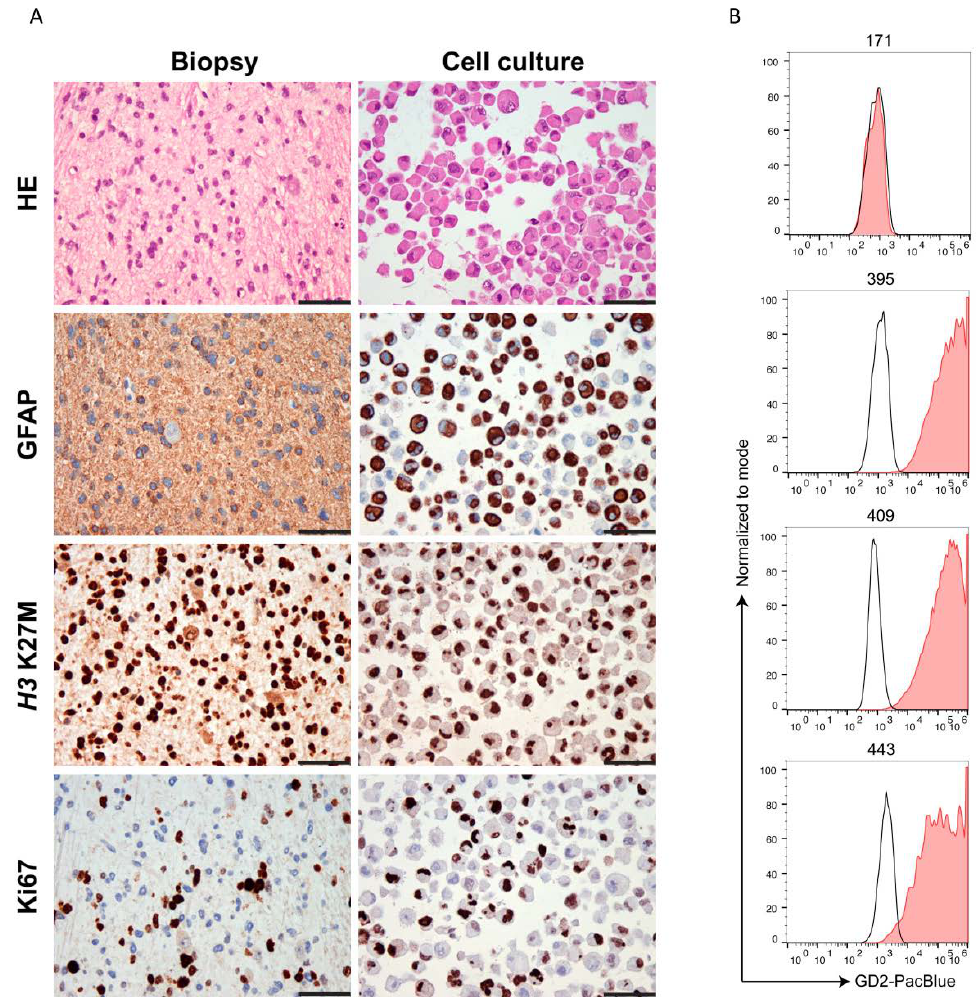
Figure 3. H3K27M-mutant DMG express high and homogeneous amount of GD2. ( A ). Validation of H3K27M-mutant DMG primary cells. Primary tumor cells of patient no. 395 were embedded in paraffin, stained with hematoxylin eosin (HE), and further analyzed by IHC with the indicated antibodies. The tumor used for the isolation of the primary cells was used as reference (biopsy, left panel). The H3K27M mutation was maintained in the cell culture. GFAP and Ki67 staining was similar between the biopsy and the primary cells. Scale bar: 50 µ m. Similar results were obtained with sample 409. ( B ). Expression of GD2 in CNS tumors. Primary tumor cells were analyzed by flow cytometry with an anti-GD2 antibody. 171 cells derive from HGNET-BCOR, sample no. 395 and no. 409 from H3K27M-mutant DMG and no. 443 from DNET. Unstained samples were used as negative controls (black